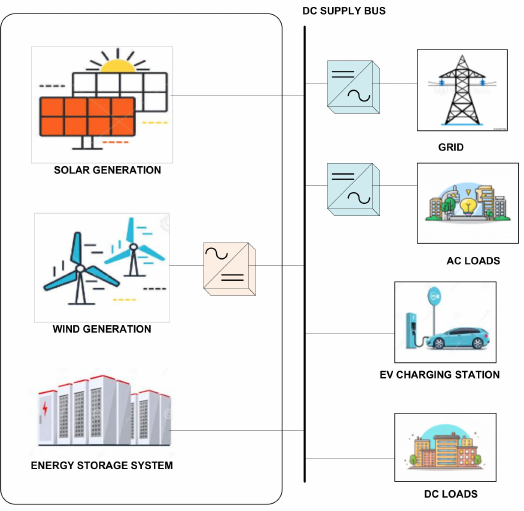
Figure 5. Structure of a DC microgrid.